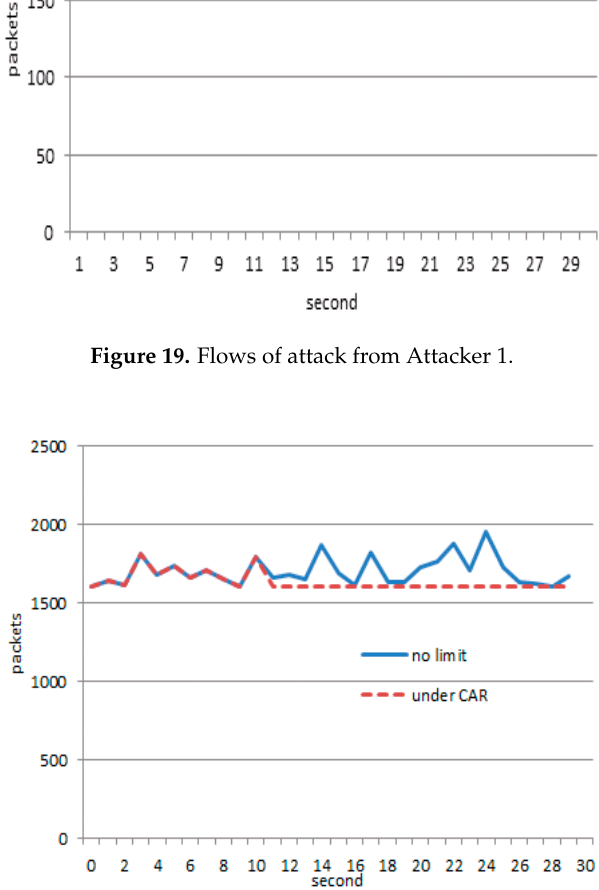
Figure 20. Throughput to the server under committed access rate (CAR) (30 s).